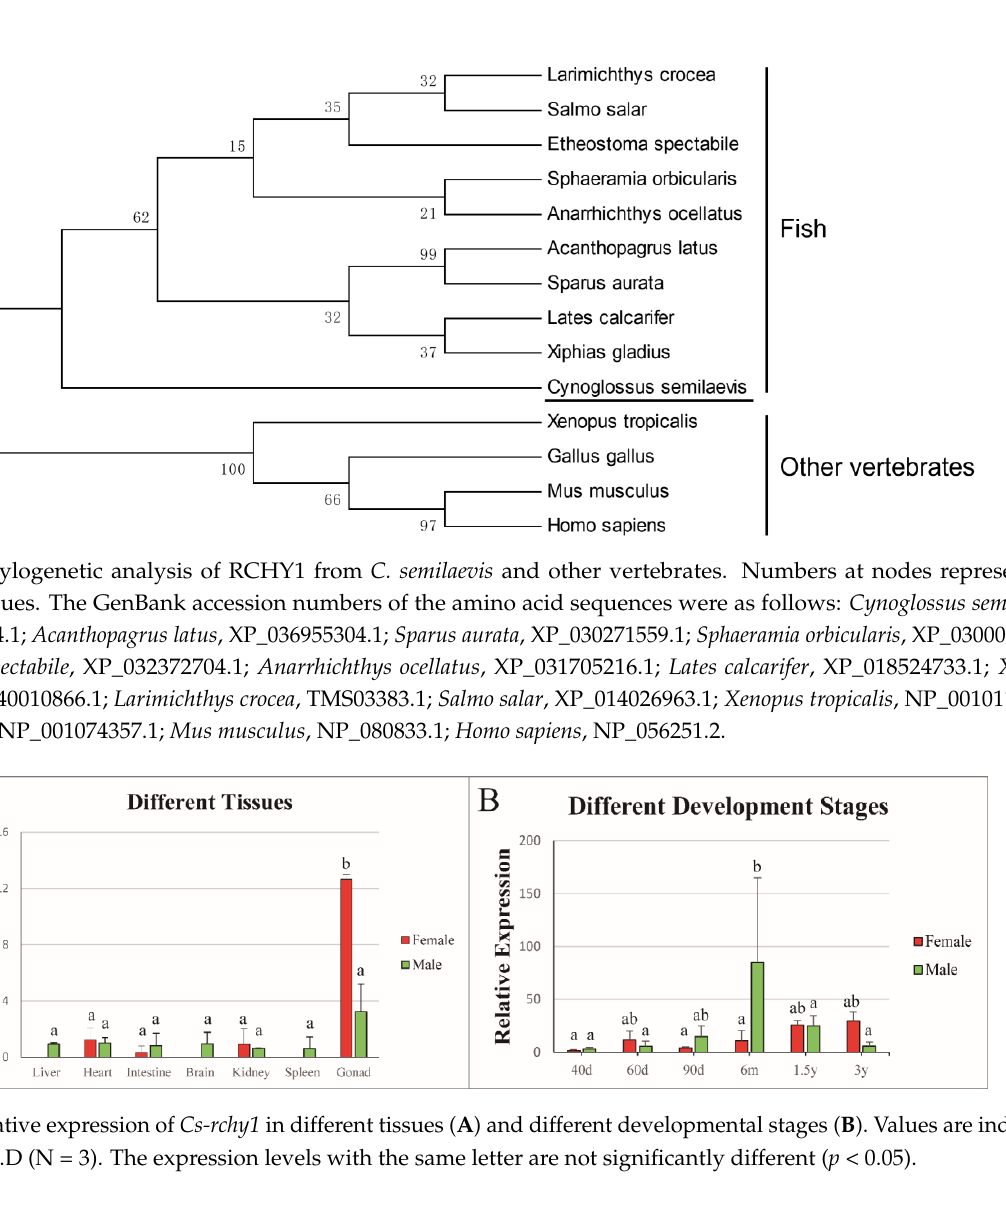
Figure 3. Relative expression of Cs-rchy1 in different tissues ( A ) and different developmental stages ( B ). Values are indi- cated as means ± S.D (N = 3). The expression levels with the same letter are not significantly different ( p < 0.05).